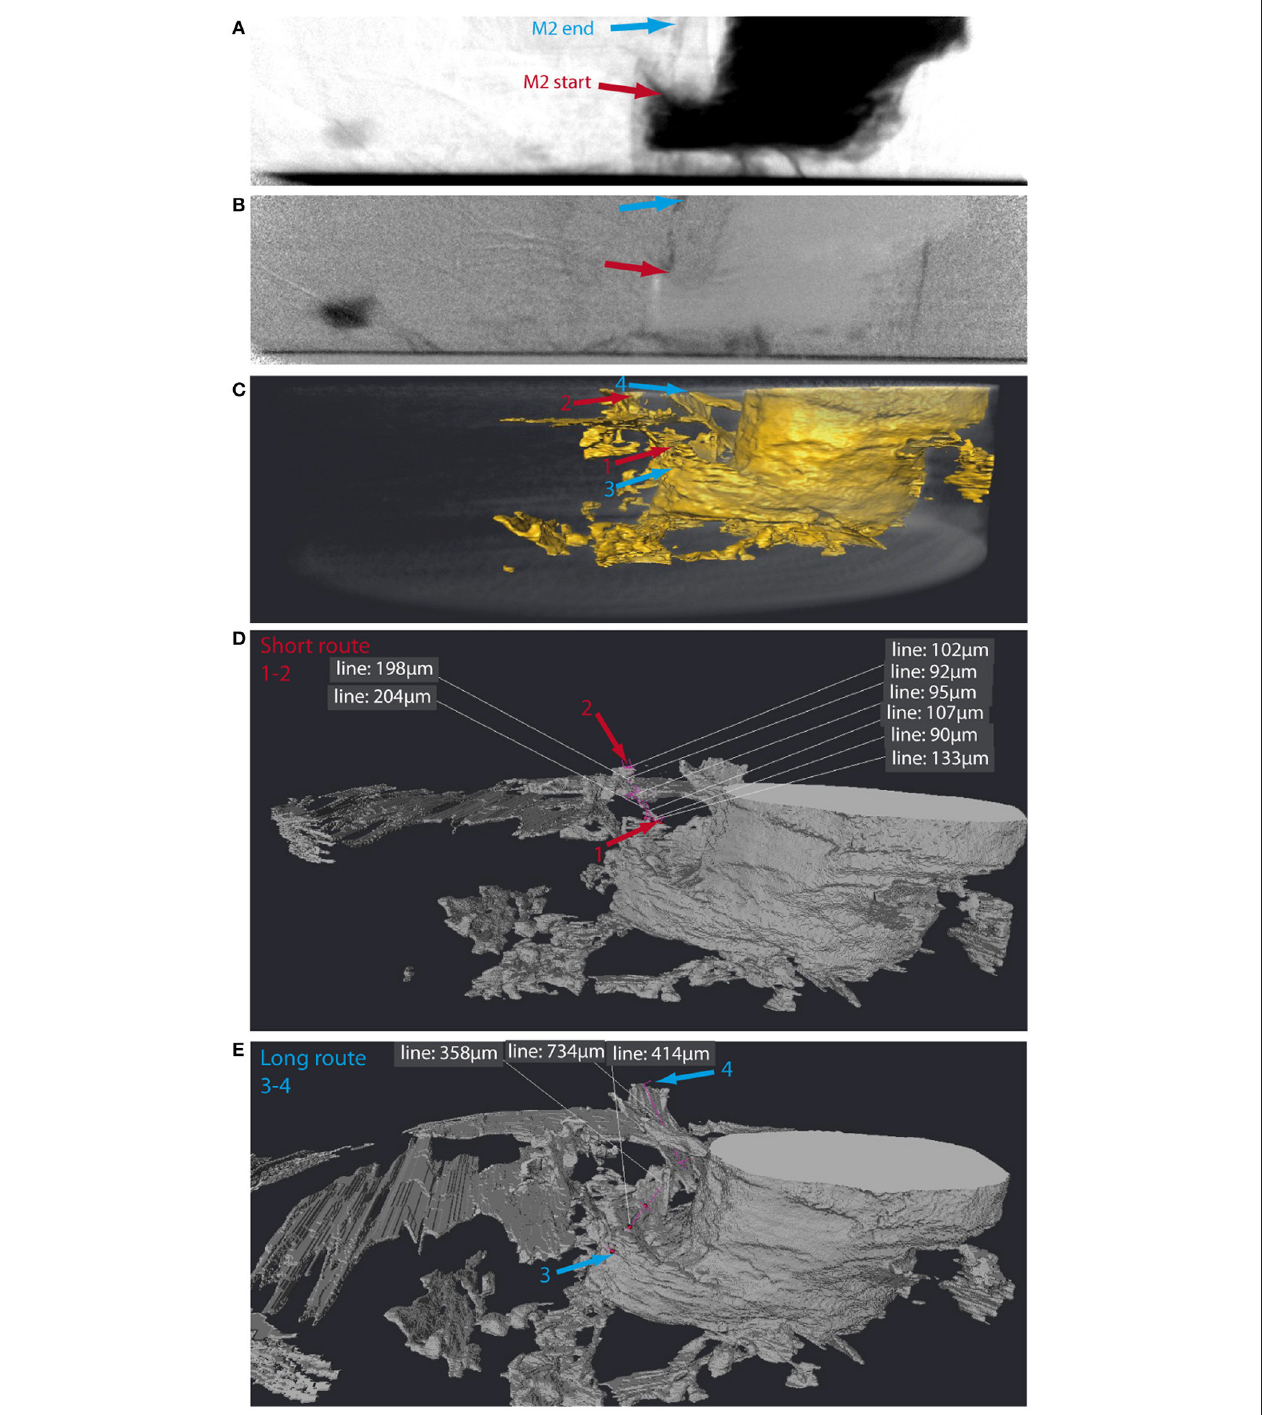
FIGURE 9 | Matching melt migration event M2 in 2D radiographs to 3D tomographic reconstructions. (A) An example of an original radiographic projection (p 70 ), with approximate start and end positions for the observed melt movement labeled (from Figure 6 ). (B) Image p 70 -p 0 highlighting melt movement in the projection. (C) 3D tomographic reconstruction. In this instance it is more difficult to identify the exact melt channel as there are multiple possibilities, i.e., start and end positions. Estimates of the shortest and longest routes are shown. In this case, 2D radiography shows good evidence for melt movement along a pre-existing fracture network. (D) Measurements of the shorter route between start and end locations, with an intermediate, slightly more convoluted route (mid-estimate). (E) Measurements of the longest estimated route from the sample middle (3) to the edge of the field of view.